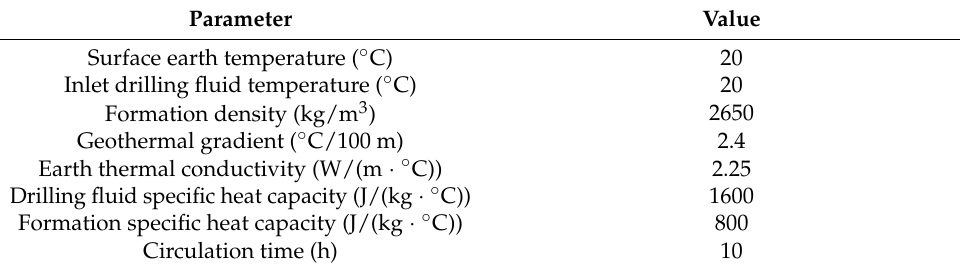
Table 3. Main parameter settings for wellbore temperature calculation.